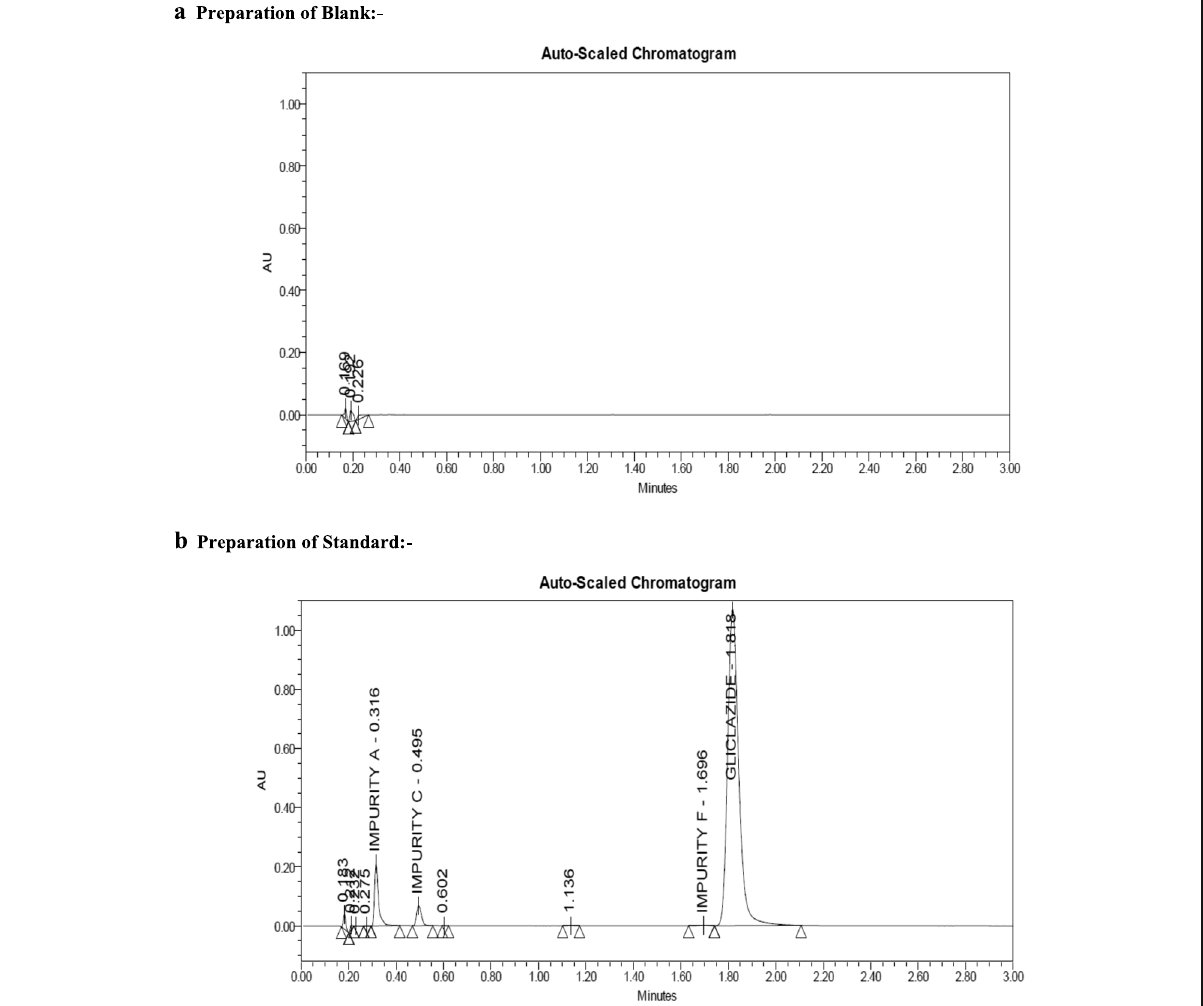
Fig. 4 UPLC chromatograms of blank preparation and standard preparation. a Unspiked standard sample. b Spiked standard